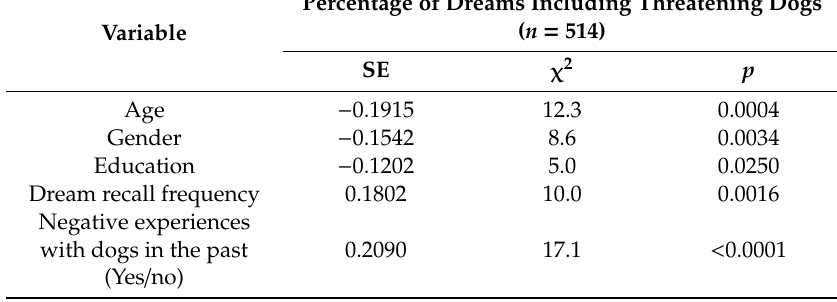
Table 7. Ordinal regression analysis for the categorized (ordinal) percentage of dreams that include threatening